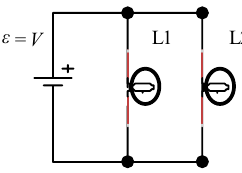
Fig. 1. Two lamps connected in parallel with an ideal